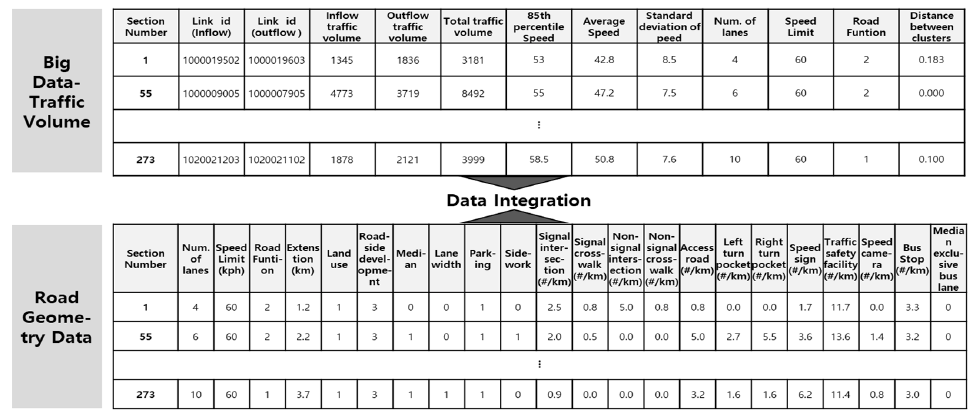
Figure 5. Big data integration and parameter setting.